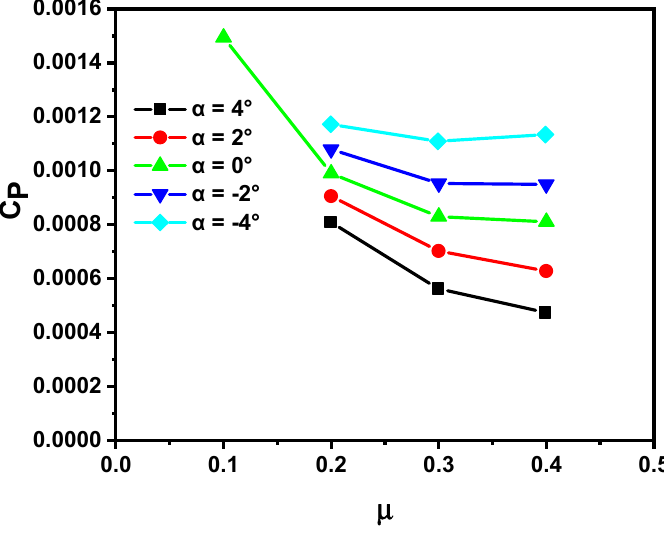
Figure 9. Power coefficient (C P ) as a function of the advance ratio ( μ ), 1860 rpm.